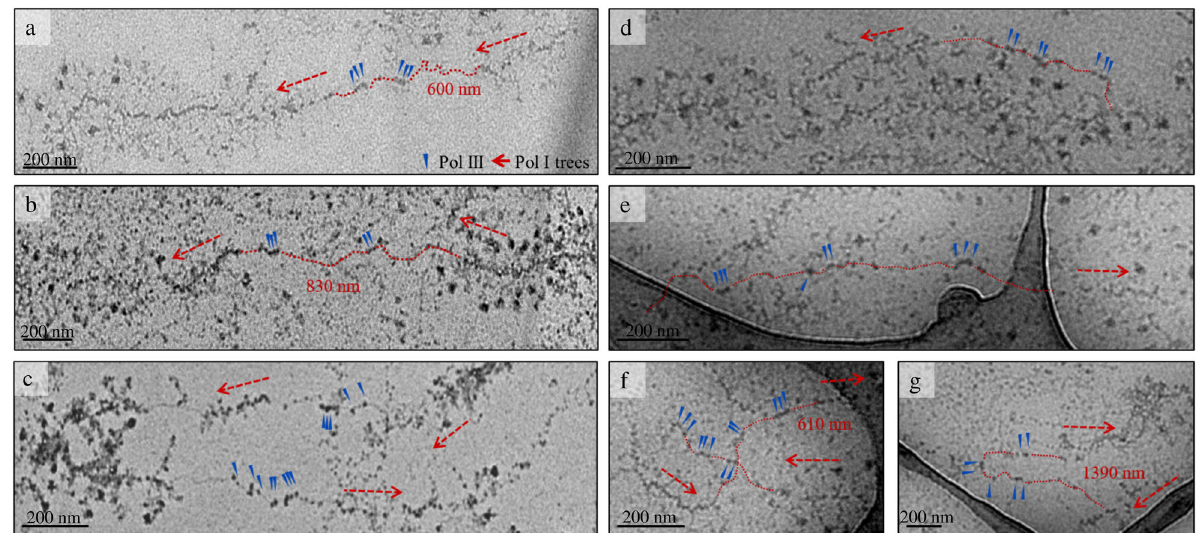
Fig. 3 Electron microscopic analysis of TFIIIA overexpression in 5x(O)RDN5. a – c Miller trees in chromatin spreads of the edited clone 5x(O) RDN5 . Groups of RNA Pol III complexes on endogenous and incorporated RDN5 genes are visible between Miller trees. d – g Spreads of clone 5x(O) RDN5 with TFIIIA overexpression. The samples were positively stained with UA and PTA; EM images were acquired at 12,000× magni fi cation at a defocus of ‒ 40 µ m. Red dashed arrows label the start or end of a Miller tree and its direction. Red dashed lines show the route of the DNA between Miller trees. In ( a , b , f , and g ), the length of the intergenic spacer is indicated in red. Blue arrowheads label Pol III complexes.